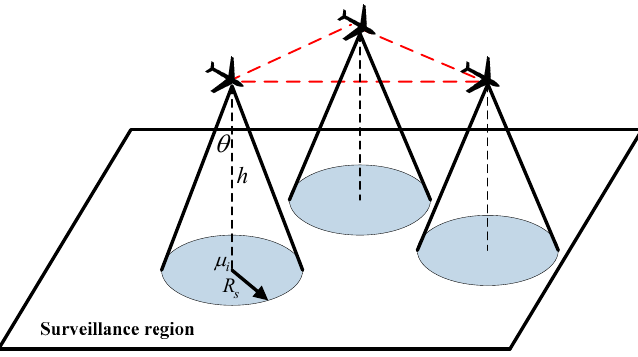
Figure 2. Sensor model in multiple UAVs cooperative surveillance.